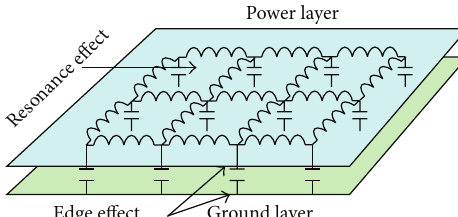
Figure 1: Resonance effect and edge effect.